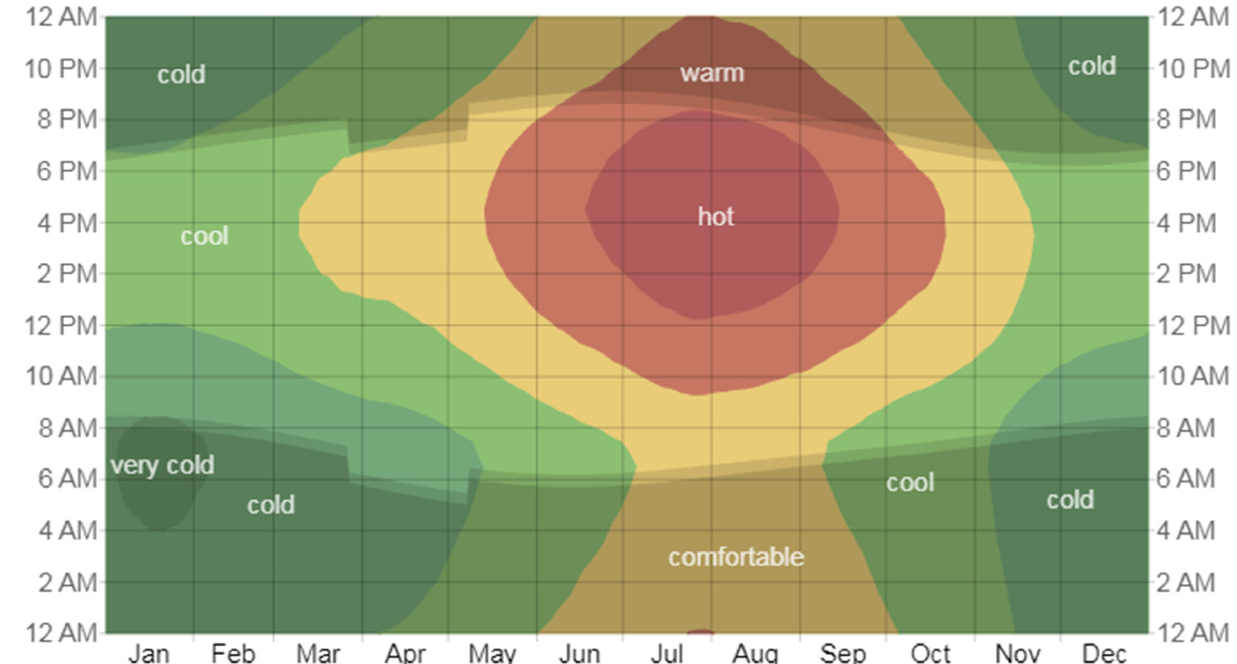
Figure 5. Average Hourly Ambient Temperature in the Region of Fez-Meknes.